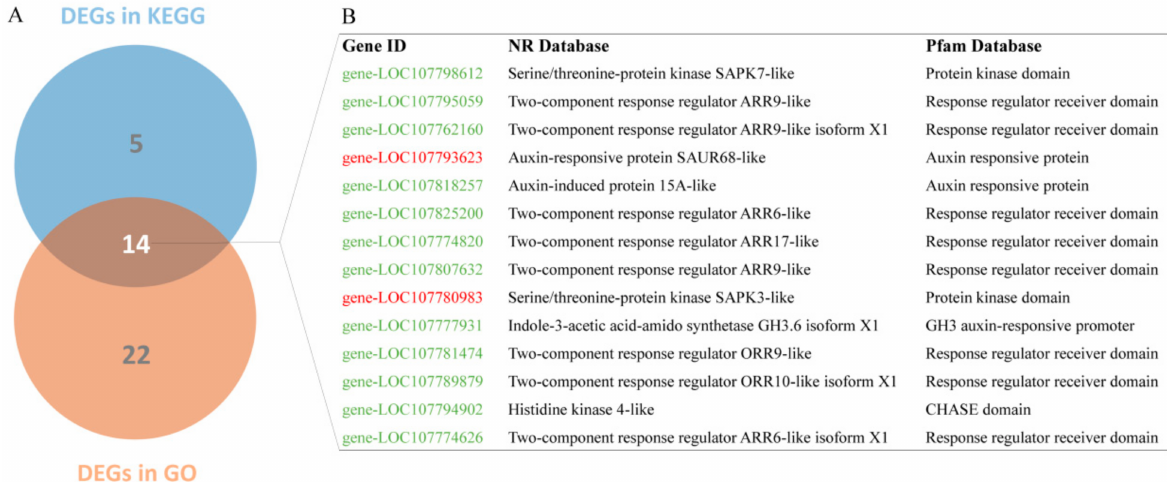
Figure 4. Screening of DEGs involved in plant hormone signal transduction. ( A ) The Venn diagram analysis of plant hormone signal transduction related DEGs from KEGG and GO analysis. ( B ) The annotation information of 14 common DEGs from NR and Pfam online databases. Red and green color genes represent up-regulated and down-regulated DEGs,